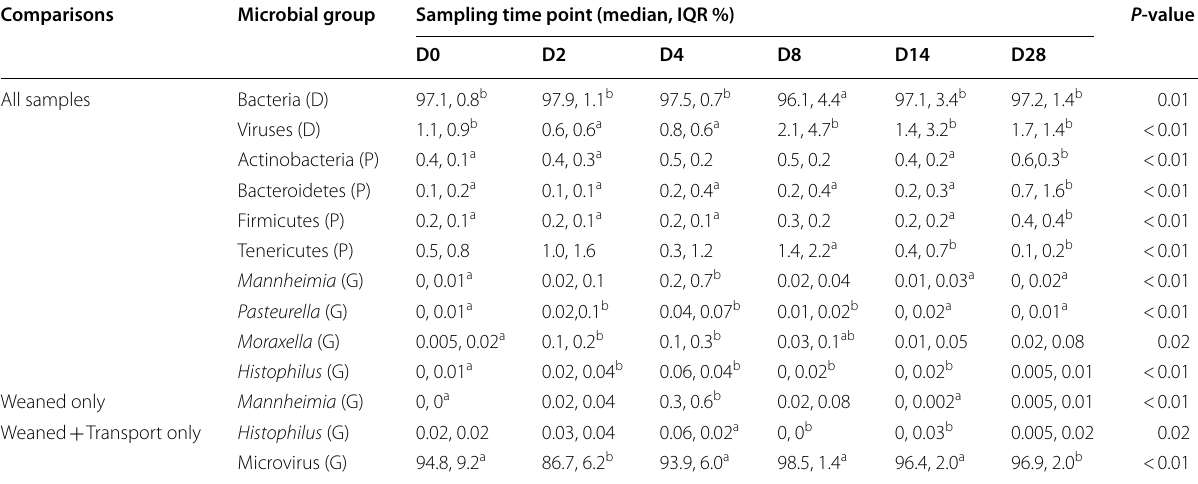
D, domain (median as a % of all assigned domains); P, Phylum (median as a % of all assigned phyla within bacteria), G, Genus (median as a % of all assigned genera within bacteria or viruses); IQR, inter quartile ration a,b Median with different superscripts are different at P < 0.05 (Post-hoc test for multiple comparisons of sampling time point using pairwise Wilcox test)